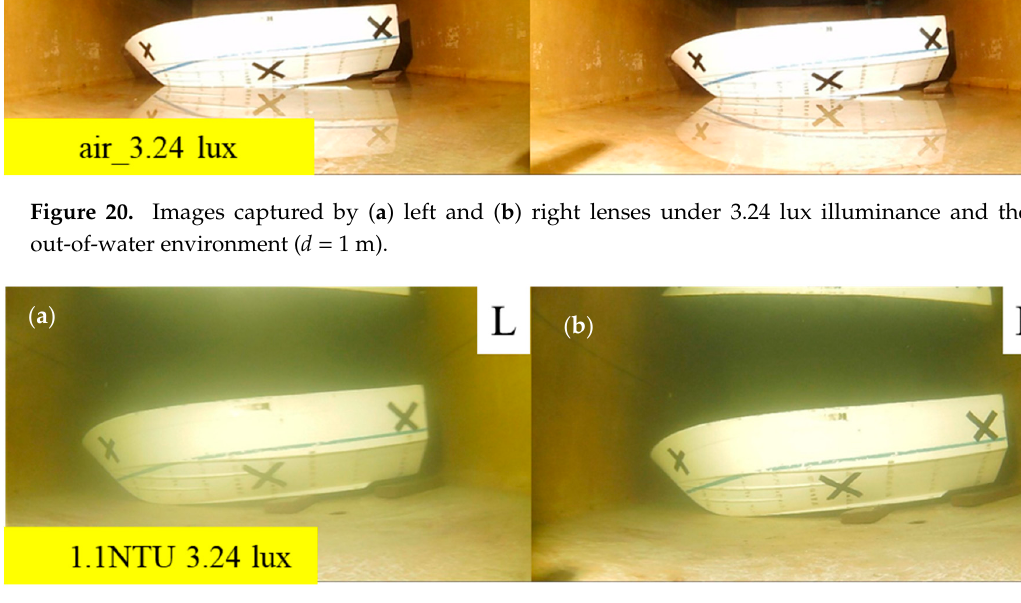
Figure 21. Images captured by ( a ) left and ( b ) right lenses under 1.1 NTU (Nephelometric Turbidity Units) turbidity and 3.24 lux illuminance in the underwater environment ( d = 1 m).